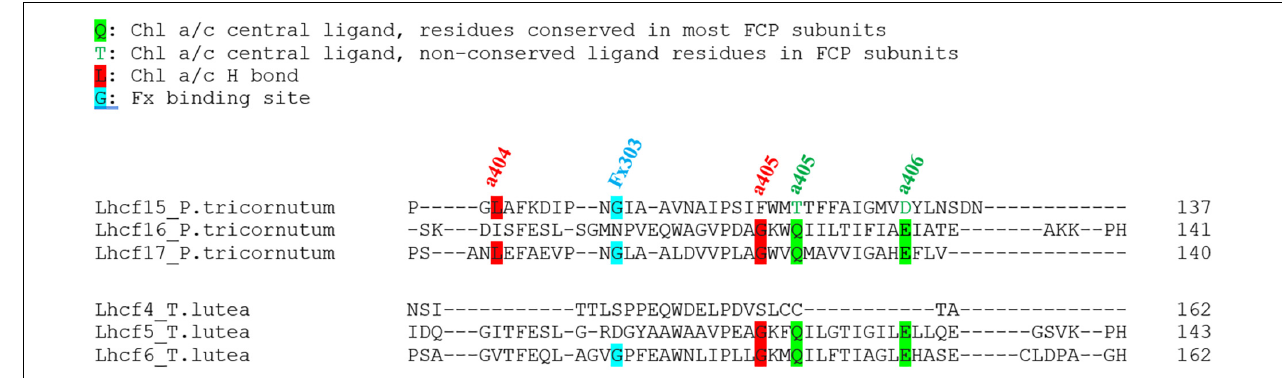
FIGURE 3 | Example of a part of the alignment of three Lhcf sequences of P. tricornutum and three Lhcf sequences of T. lutea with binding sites of three Chl a (a404, a405, and a406) and one Fx (Fx303). TABLE 2 | Binding sites of Chl a and c amino acid (in capital letters) in Tisochrysis lutea according to those identified in Phaeodactylum tricornutum (Wang et al., 2019a). Central ligand H bond Chl identified in P. tricornutum Conserved % among Lhcf Not conserved % among Lhcf % among